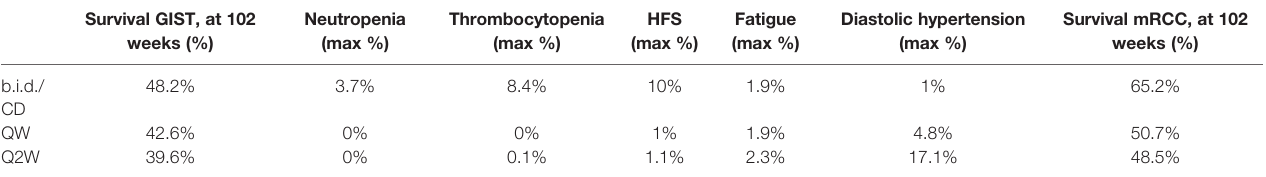
TABLE 1 | Ef fi cacy and safety under sunitinib CD (37.5mg), QW (300 mg), and Q2W (700 mg) dosing for GIST; Ef fi cacy under axitinib b.i.d. (5 mg), QW (70 mg), and Q2W (140 mg) dosing for mRCC. Survival GIST, at 102 weeks (%)